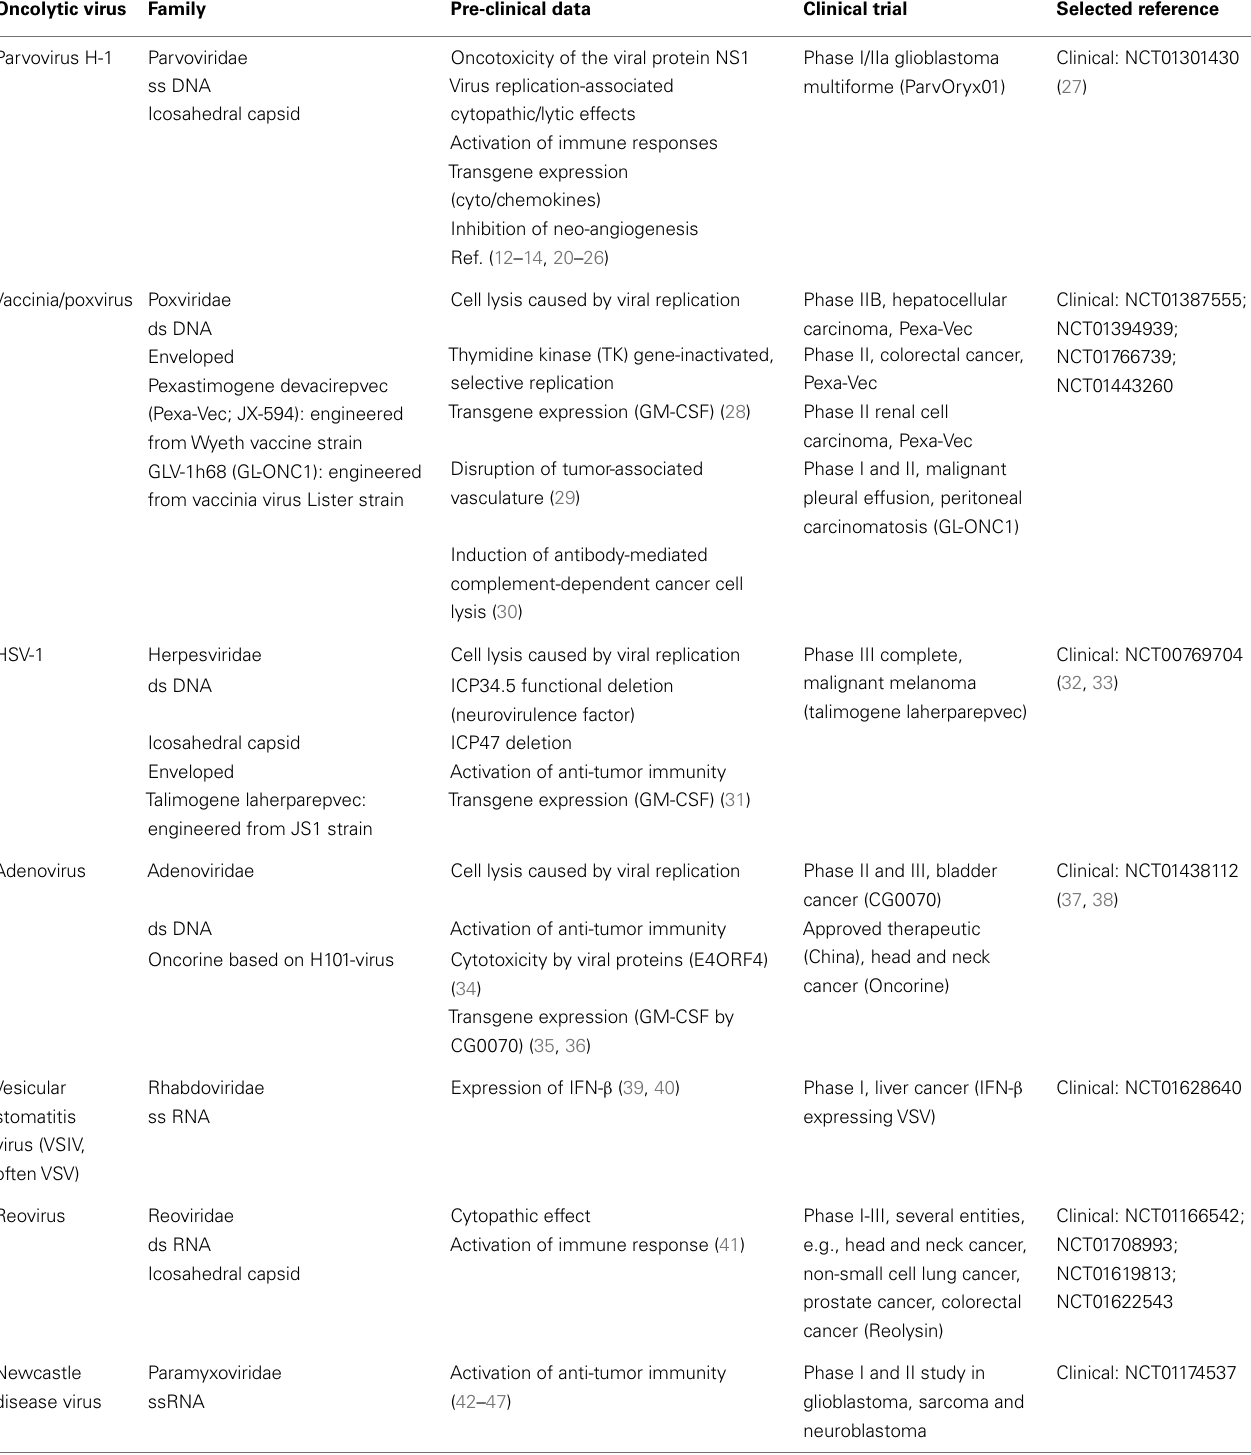
Table 1 | Oncolytic viruses